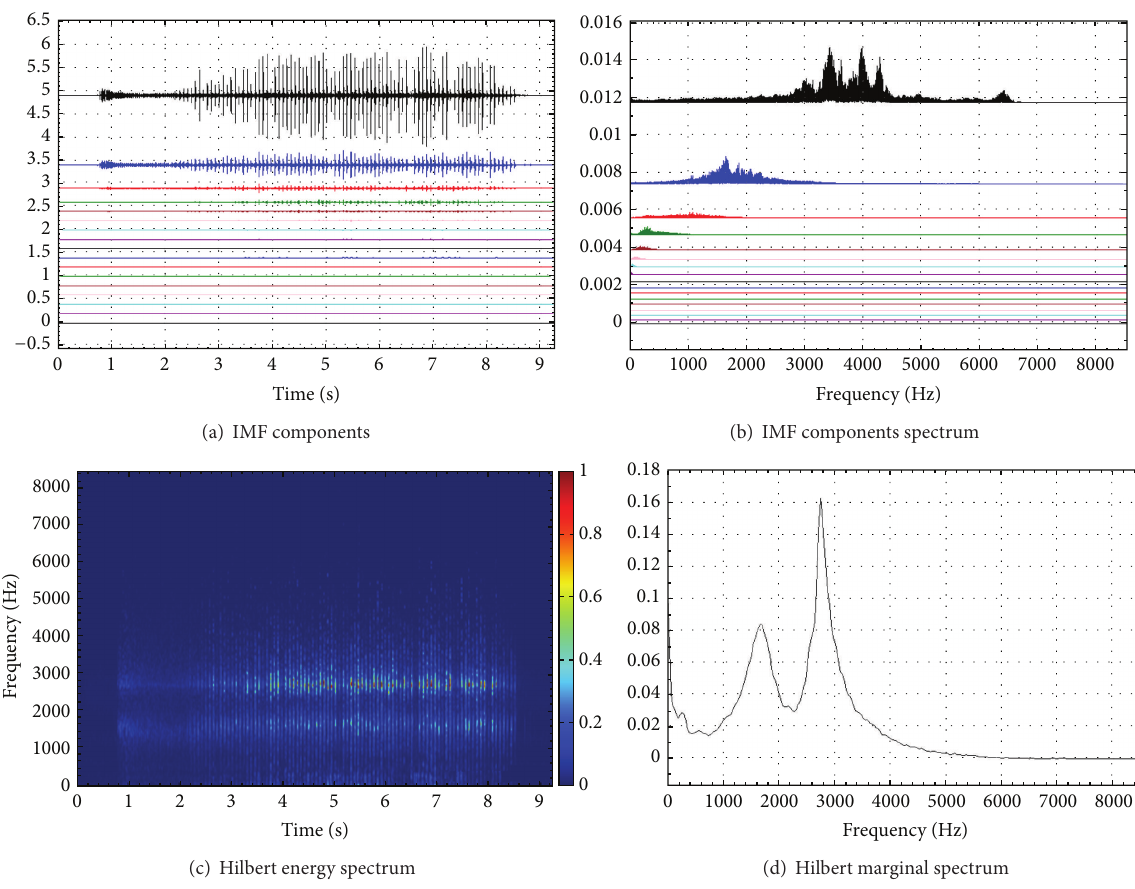
Figure 35: HHT analysis results in working condition